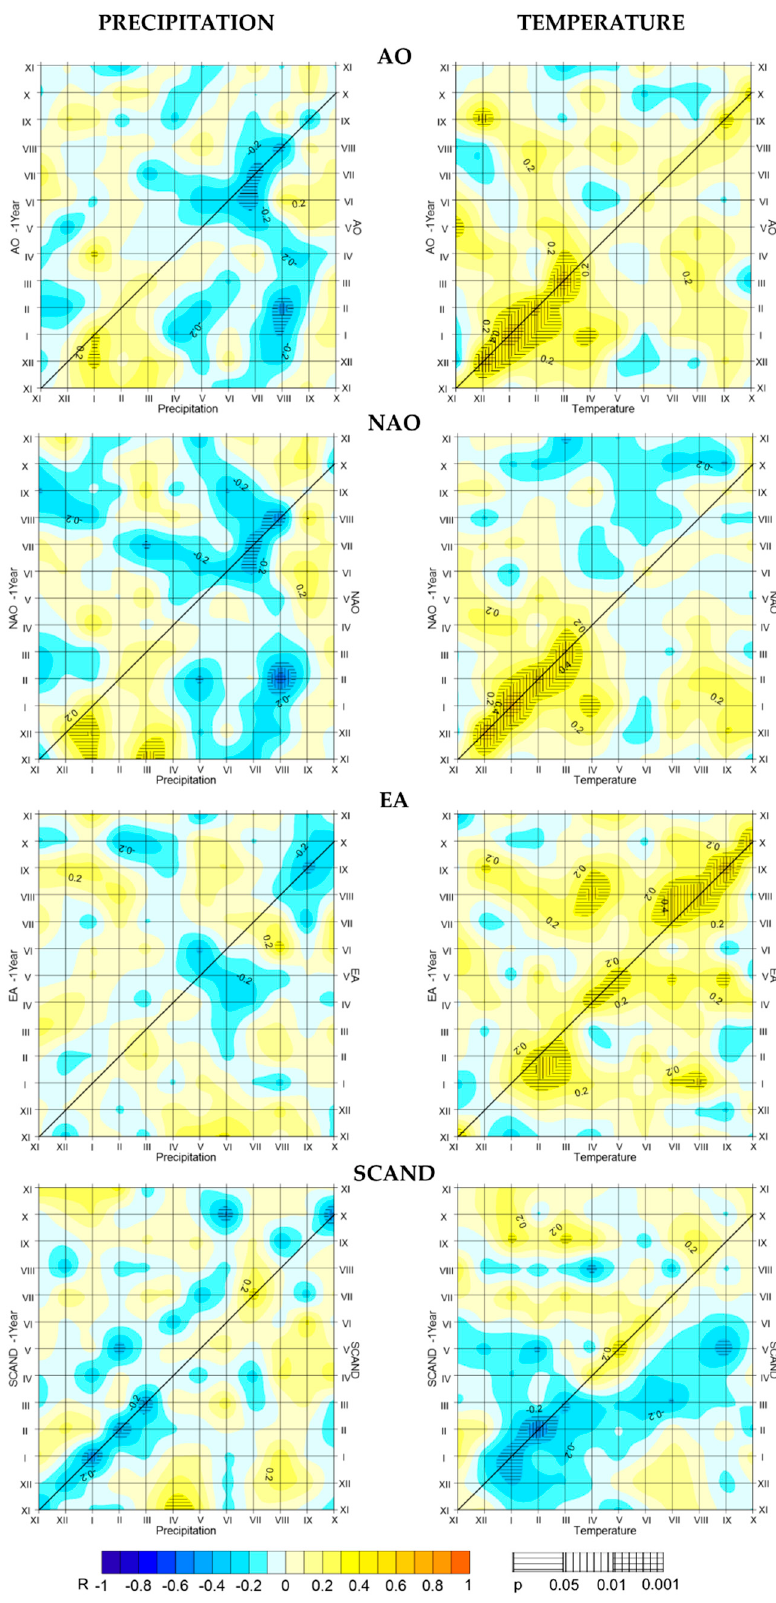
Figure 10. Matrices of coefficients of correlation for temperature and precipitation in Olsztyn station in considered circulation types.